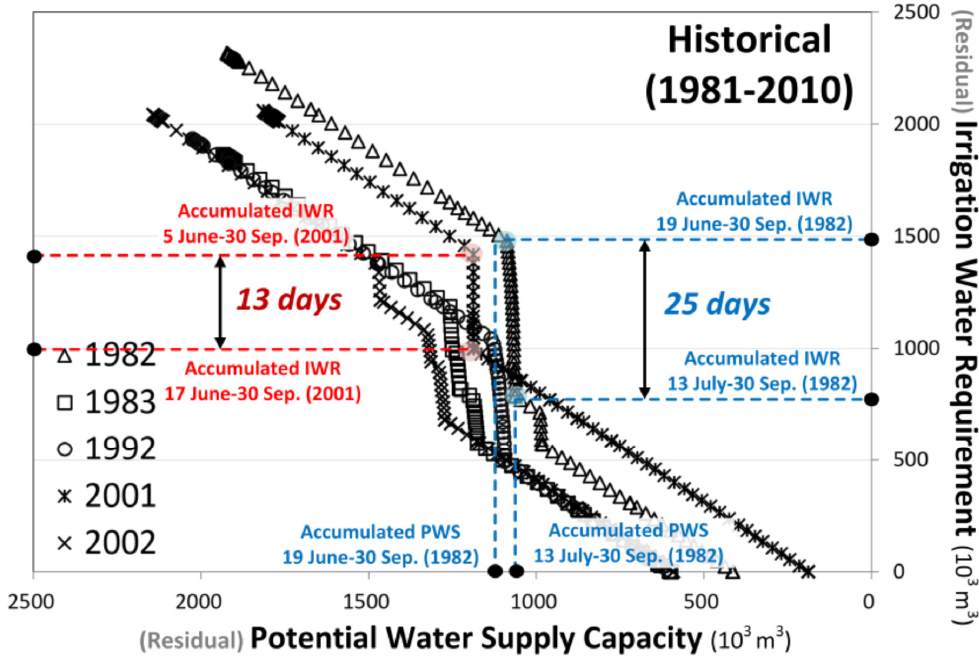
Figure 6. Distribution changes in the irrigation water requirement and the potential water supply capacity as determined by the drought year during the historical period in the agricultural reservoirs of the central region: Res. A.